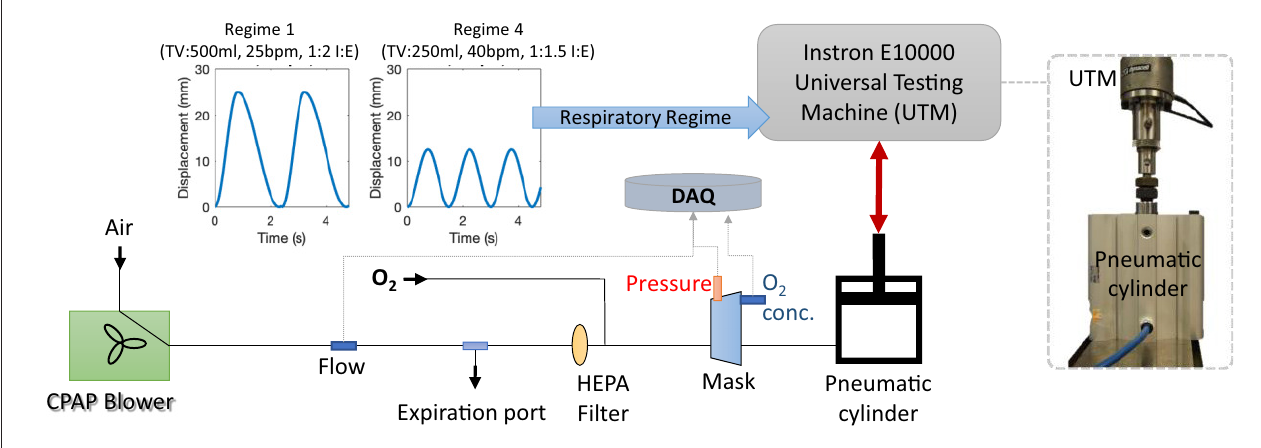
FIGURE 5 | The breathing model and test configuration used to evaluate the LeVe systems. The pneumatic cylinder can be driven by the Universal Testing Machine to simulate different respiratory regimes, as defined by Tidal Volume (TV), Breaths per Minute (BPM) and the Inspiration:Expiration ratio (I:E). All data were logged to the data acquisition system (DAQ).